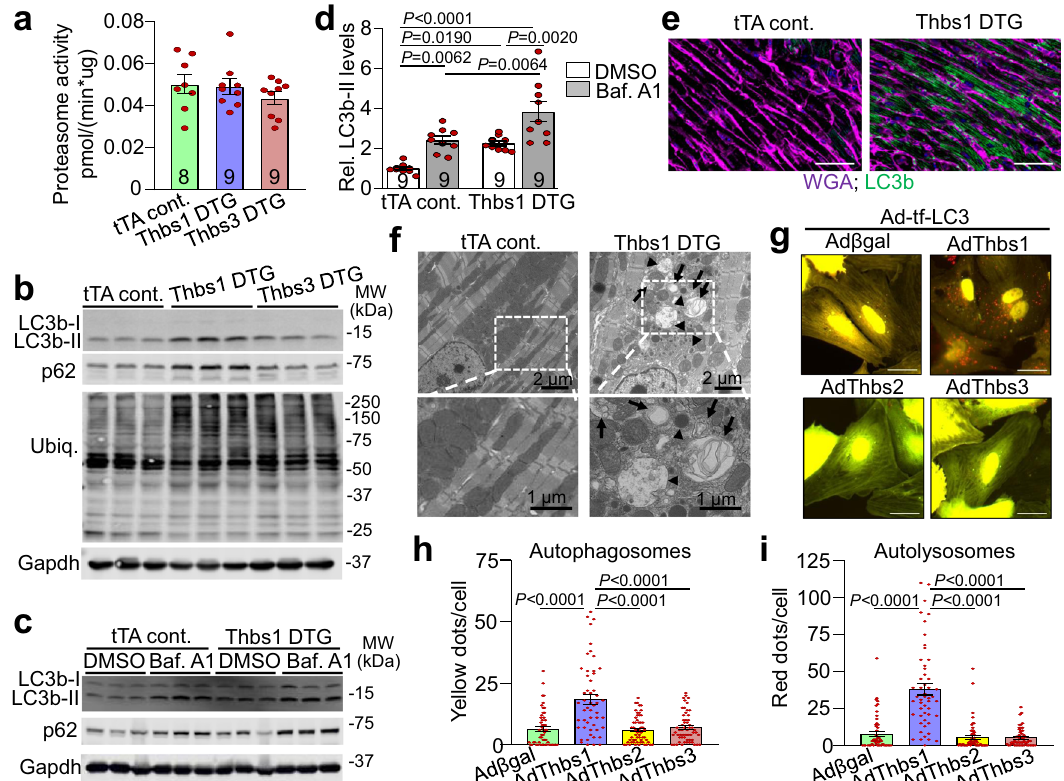
Fig. 5 Thbs1 induces autophagy and lysosomal protein degradation. a 20S chymotrypsin-like proteasome activity measured in heart tissue of tTA cont., Thbs1 DTG, and Thbs3 DTG mice at 4 weeks of age. b Representative western blots for LC3b, p62, ubiquitin-conjugated proteins (Ubiq.), and Gapdh as loading control from hearts of tTA cont., Thbs1 DTG, and Thbs3 DTG mice at 4 weeks of age. c Representative western blots for LC3b, p62, and Gapdh as loading control from hearts of tTA cont., Thbs1 DTG treated with dimethyl sulfoxide (DMSO) as vehicle or ba fi lomycin A1 (Baf. A1) to inhibit autolysosome degradation at 6 weeks of age. d Quantitative analysis of LC3b-II protein levels relative to Gapdh from the experiment shown in “ c ” . Analysis of p62 protein levels is shown in Supplementary Fig. 3c. Data are represented as fold change compared to tTA cont. with DMSO. e Representative immunohistochemistry for LC3b protein (green) and WGA (purple) from heart sections of tTA cont. and Thbs1 DTG mice at 8 weeks of age. Scale bars are 50 μ m. f Representative transmission electron microscopy of Thbs1 DTG and tTA cont. heart sections at 6 weeks of age. Autophagosomes (arrow) appear as double-membrane vesicles while autolysosomes are single membrane structures (arrowheads). Lower panels are enlargements of white dotted boxed area from upper panels. Scale bars are 2 μ m and 1 μ m, respectively. g – i Representative micrographs of fl uorescent LC3 puncta ( g ) and quanti fi cation thereof ( h , i ) in cultured primary neonatal rat ventricular myocytes 48h after infection with indicated adenoviruses to overexpress tandem mRFP-GFP-LC3 (Ad-tf-LC3) indicator with either Thbs1 ( n = 51), Thbs2 ( n = 57), Thbs3 ( n = 57), or β gal control ( n = 53). ‘ N ’ represents biologically independent cells; yellow dots represent autophagosomes, whereas free red dots indicated autolysosomes. Scale bars are 50 μ m. The number of biologically independent animals analyzed for “ a ” and “ d ” is indicated on each graph. All statistical analysis were performed using one-way ANOVA and Tukey multiple comparisons test; error bars are ±standard error of the mean; P -values for panel d , h , i are shown in the graph. Source data are provided as a Source